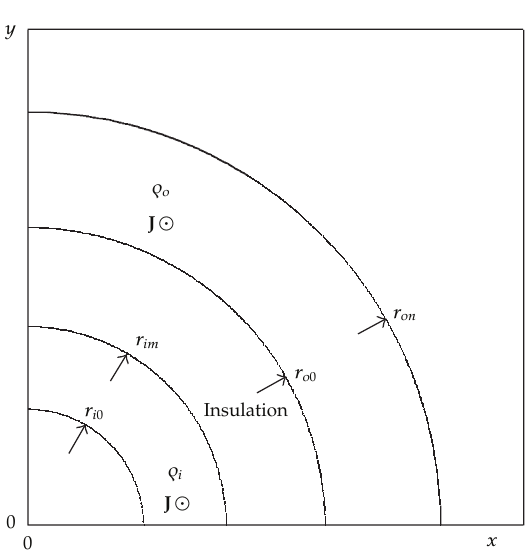
Figure 2: A quarter of the cross-section of composite